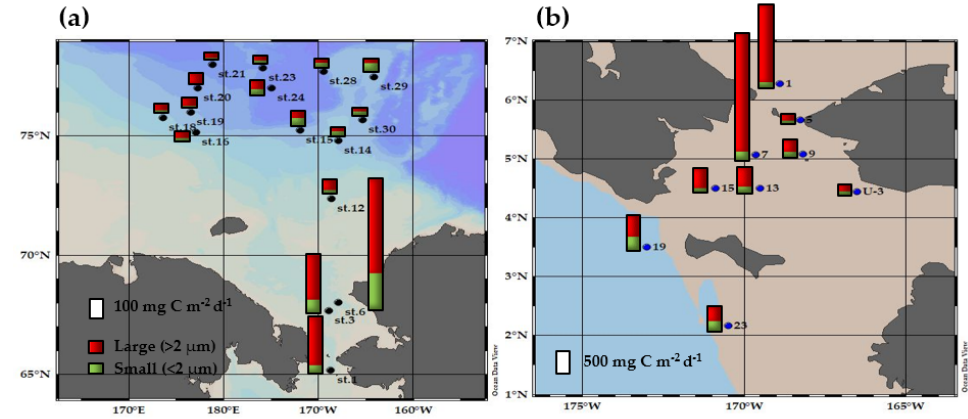
Figure 9. Primary production of small phytoplankton of ( a ) ARA07B and ( b ) OS040. Overall, the primary productions of total and small phytoplankton communities during the study period were different depending on the sea area. Indeed, agglomerative hierarchical clustering (AHC) analysis based on 25 stations and phytoplankton size-related variables sorted stations into four distinct groups (Figure 10; Table 3). Cluster 1 include station 1 of OS040 that was high primary productive region (1992.9 mg C m − 2 d − 1 ) near Bering strait. Cluster 1 had a relative low contribution of small phytoplankton in primary productivity (5.9%) and surface chlorophyll- a (2.9%). Cluster 2 was station 7 of OS040 that was an extremely high productive station (3100.0 mg C m − 2 d − 1 ) and represented the lowest contribution of small phytoplankton among clusters. Small phytoplankton contribution to primary production was 6.9% and the contribution to surface chlorophyll- a concentration was only 0.7% for clusters 2. The physical properties of Cluster 1 (3.5 ◦ C and 32.7 psu) and 2 (5.5 ◦ C and 32.7 psu) were similar. These two clusters are influence